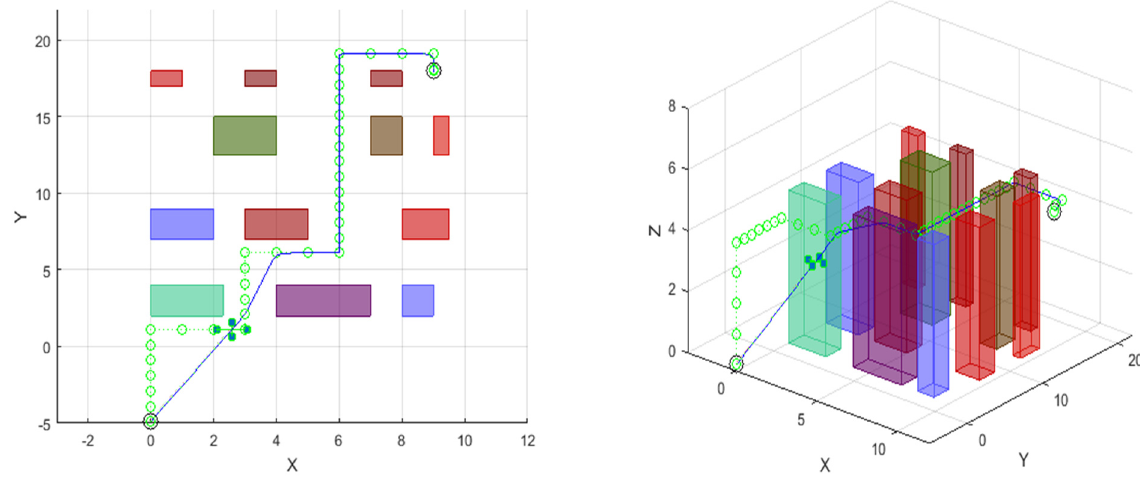
Figure 9. Trajectory traversal using the quadrotor (2D and 3D views).